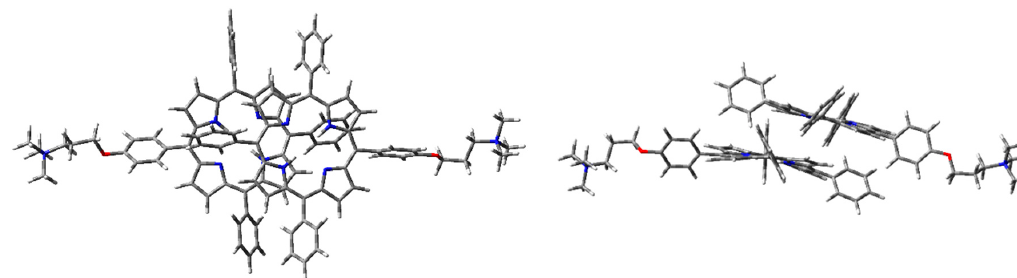
Figure 10. 1H 2 J-dimer geometry optimization in the vacuum with WB97XD functional and 6-31G(d) basis set: front ( left ) and side view ( right ).